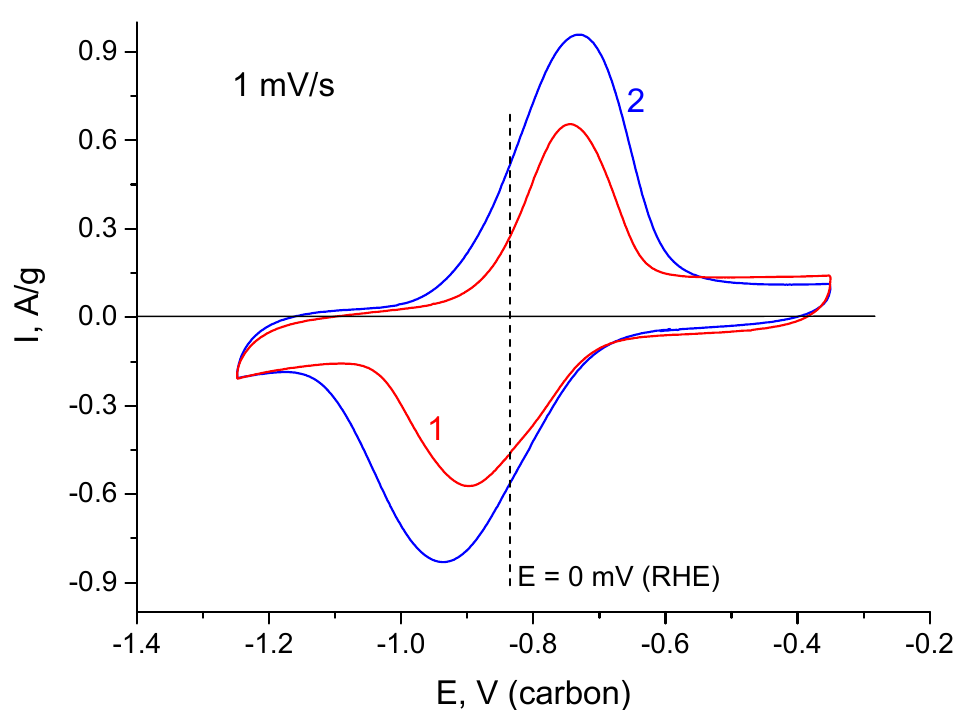
Figure 8. CVA curves (at 1 mV/s) in the field of reversible hydrogen pseudocapacitance after deep cathodic polarization: 1—rGO/TiO 2 15%; 2—rGO/TiO 2 30%.